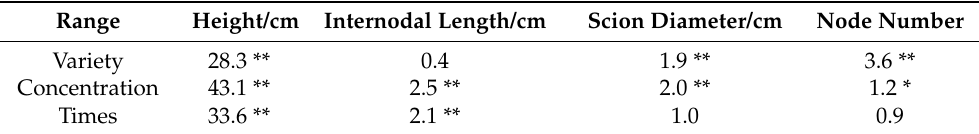
Figure 1. The effects of different PGR treatments on the height ( a ), internodal length ( b ), scion diameter ( c ), and node number ( d ) of Magnolia wufengensis L.Y. Ma et L. R. Wang. Treatment No. 10 is the control group (CK). Different small letters indicate significant differences among treatments as assessed by the Duncan’s test ( p < 0.05). Bras are means ± SDs ( n = 3). The same is shown below. Table 2. Range analysis of the L9 (3 4 ) orthogonal experimental design assessing morphological factors.